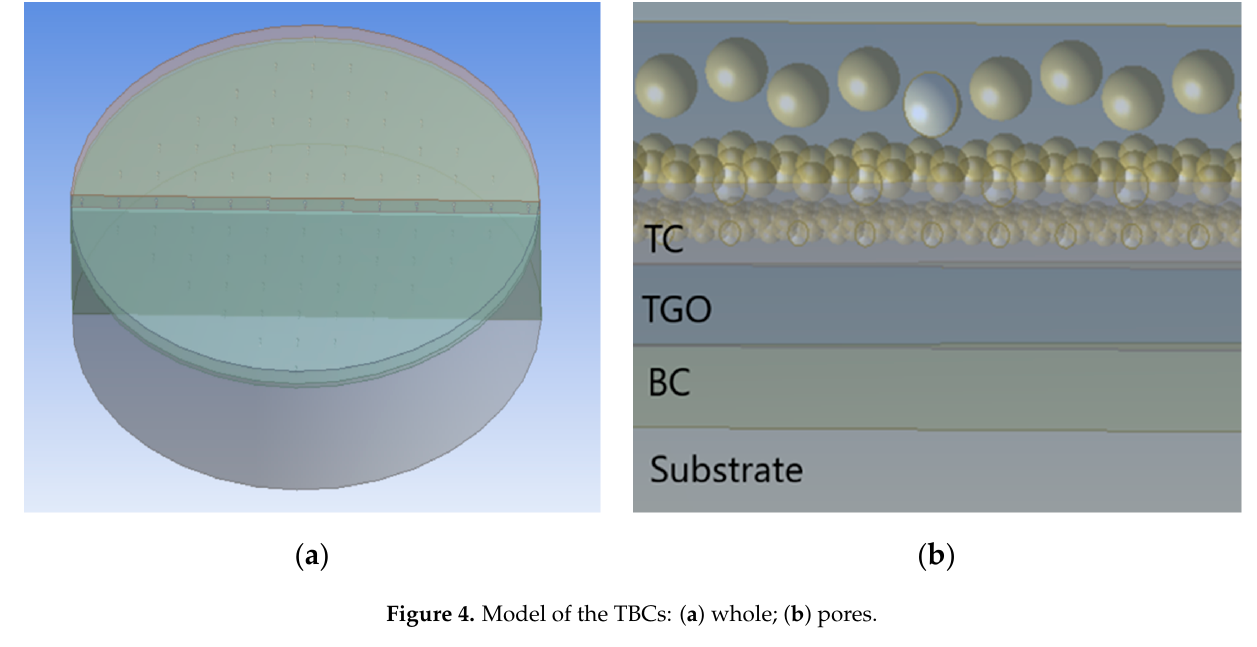
Figure 4. Model of the TBCs: ( a ) whole; ( b ) pores.